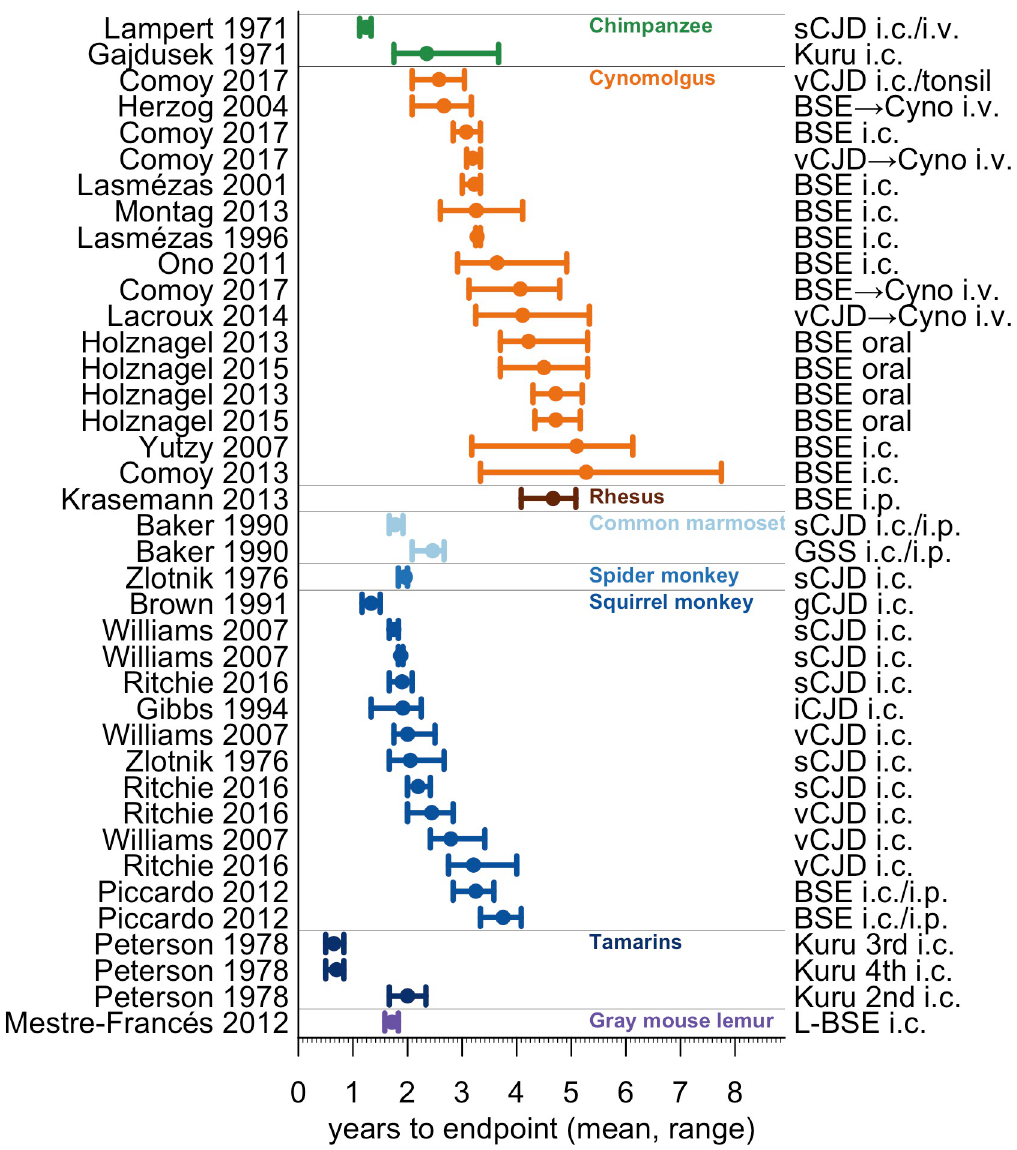
Fig 3. Duration of prion NHP studies. Cohorts for which it is possible to estimate the distribution of survival times were defined as those meeting all of the following criteria: i) containing at least N = 3 animals total, ii) with at least N = 3 reaching endpoint, iii) where all animals either reached endpoint or died of intercurrent illness, meaning none were censored at study termination, iv) where the endpoint studied was either terminal disease or symptom onset (as opposed to strictly histological outcomes), and v) for which the mean and standard deviation of survival time, or data sufficient to calculate such, were provided by the authors. The mean time to endpoint per cohort (dots), and range (bars), are shown alongside NHP species, strain and inoculation